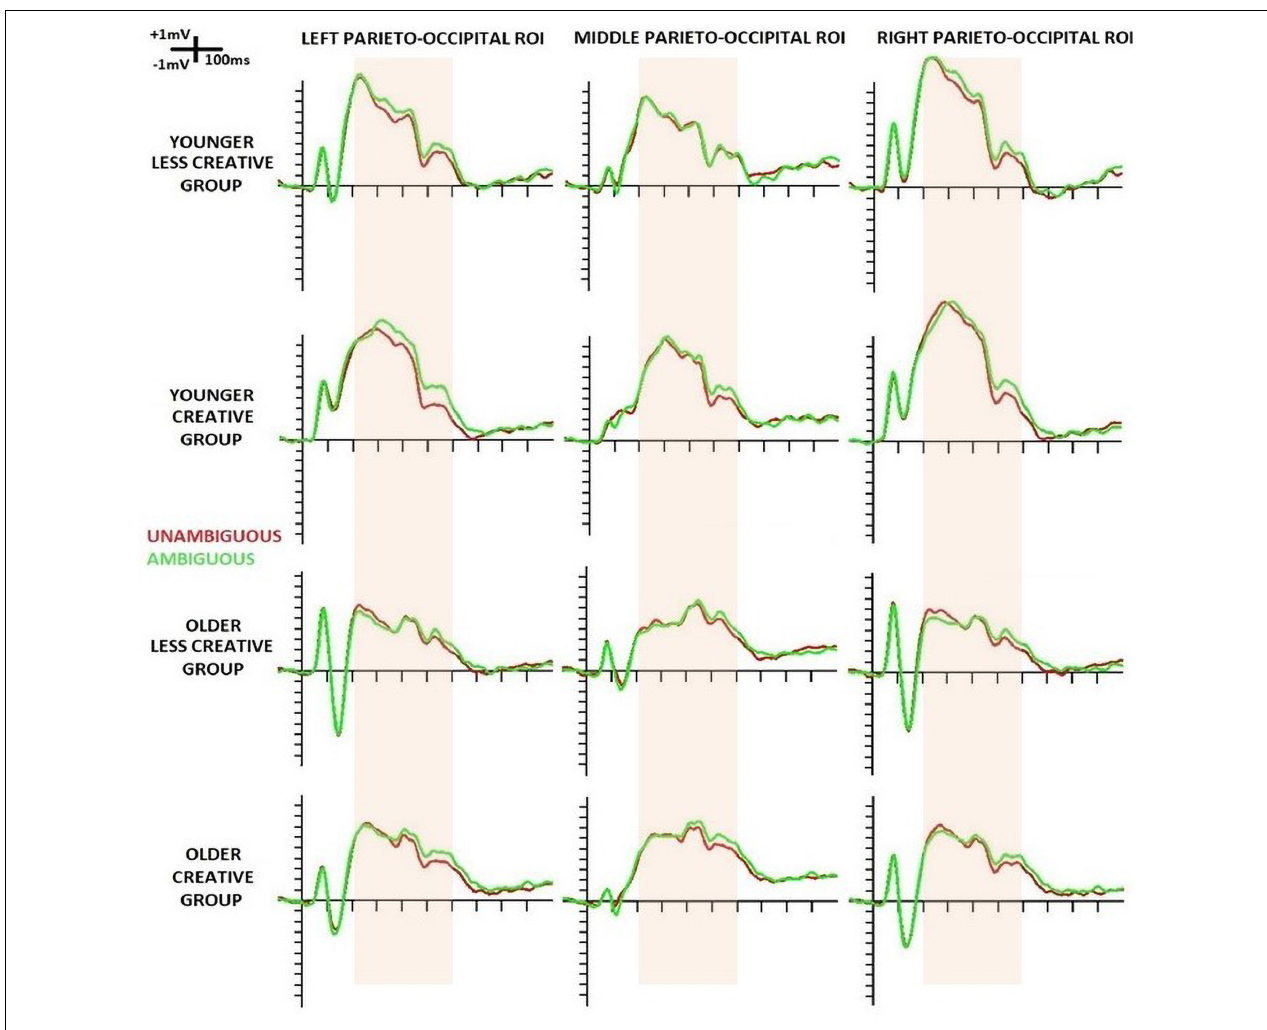
FIGURE 2 | Event-related potentials (ERPs) at left-, middle- and right parieto-occipital ROIs evoked by the standard stimuli in the four groups (younger – less creative, younger – creative, older – less creative, older – creative). ERPs for unambiguous portraits are displayed in red and for ambiguous portraits in green. The pink band shows the period in which ERP was analyzed in 100 ms-long